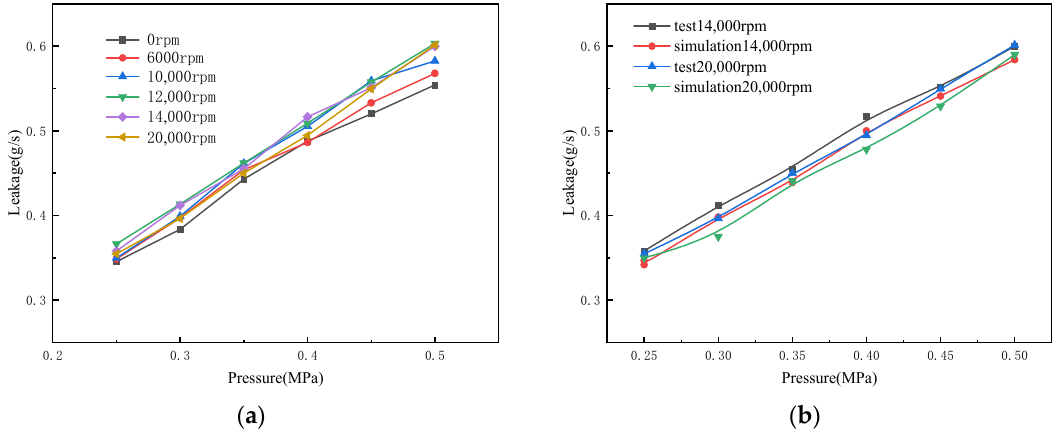
Figure 11. Leakage-inlet pressure relationship. ( a ) Test-leakage curve; ( b ) finite-element and test leakage curve.